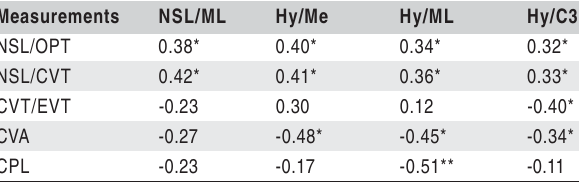
Table 2 - Correlation between craniocervical posture and the mandible and hyoid bone position